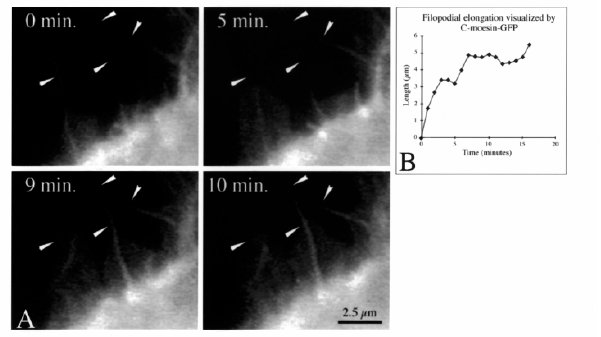
the microextension cytoskeleton are visualized by C-moesin- GFP. A 10 minute time-lapse sequence of the edge of a live, fluorescent cell is shown at high magnification in (A). The arrowheads point to the same spot in each time-frame. In (B), the growth of the middle filopodium from (A) was fol- lowed over time (17 minutes) and the changes in length/time are presented in this graph. See also three related movie files (Additional